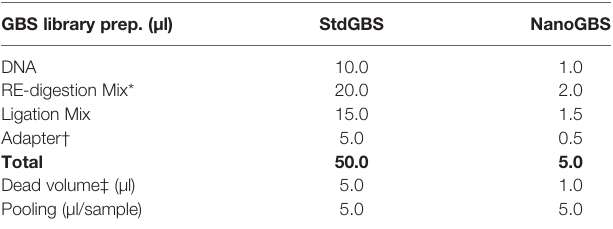
TABLE 1 | Amount of reagents used for preparation of a genotyping-by- sequencing (GBS) library based on standard GBS (StdGBS) and NanoGBS